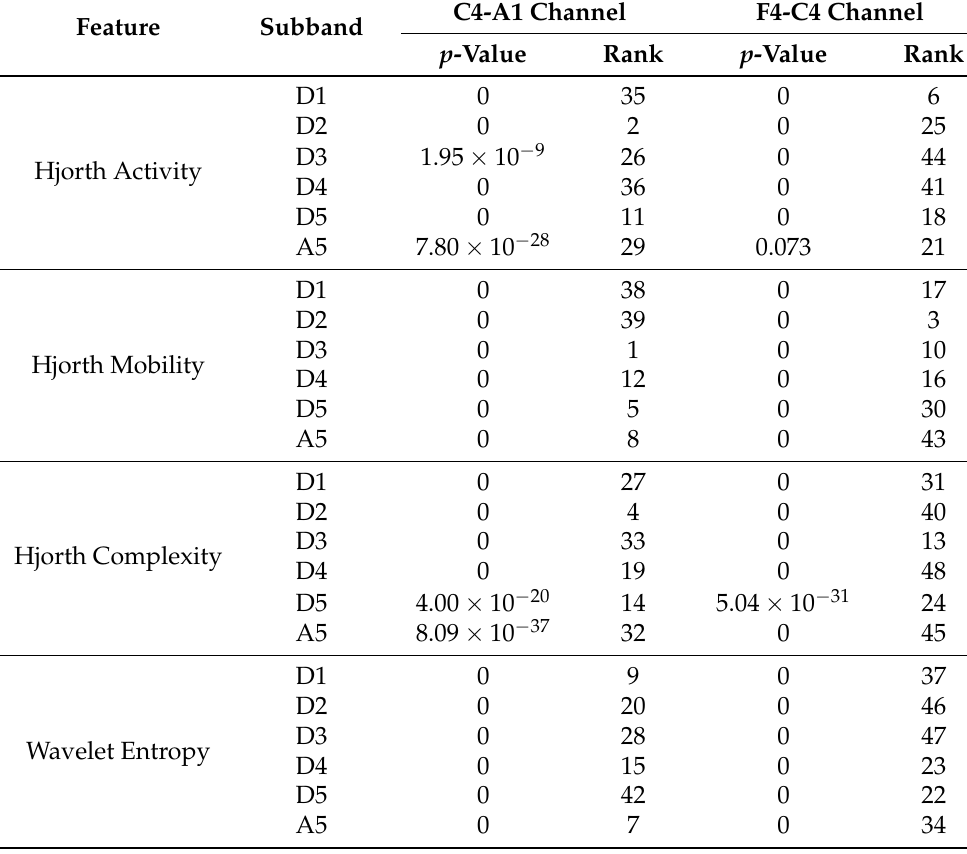
Table 3. P -value and rank for all 48 features computed using Kruskal-Wallis